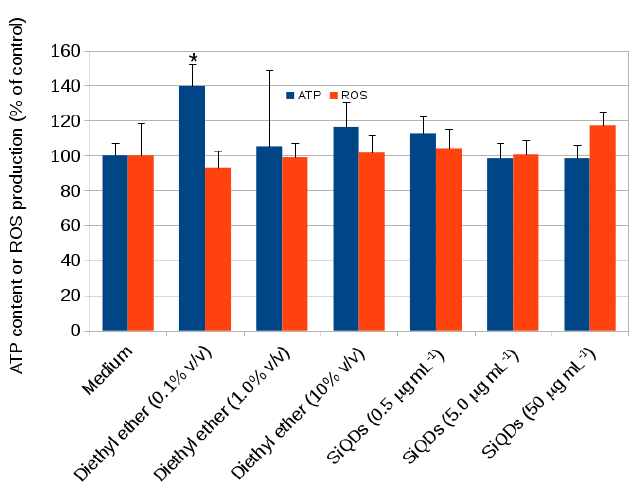
Figure 10. Cellular ATP content measured in CACO-2 cells after exposure to SiQDs for 14 days using FLASC (Sigma-Aldrich). The ATP contents (% of control) are indicated as means ± SD for n = 3 experiments. Cellular ROS content measured in CACO-2 cells after exposed to SiQDs for 14 days using H2DCFDA (Sigma-Aldrich). The ROS content (% of control) is indicated as means ± SD for n = 3 experiments. Significant effects ( p < 0.05) are marked with an asterisk